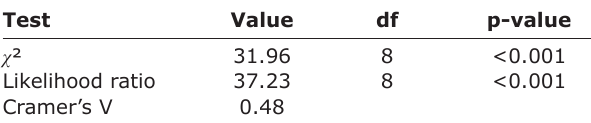
Figure-3: Risk factors with measures taken for foot-and-mouth disease outbreaks. Table-2: Chi-squared test for seniority and educational level of the surveyed breeders